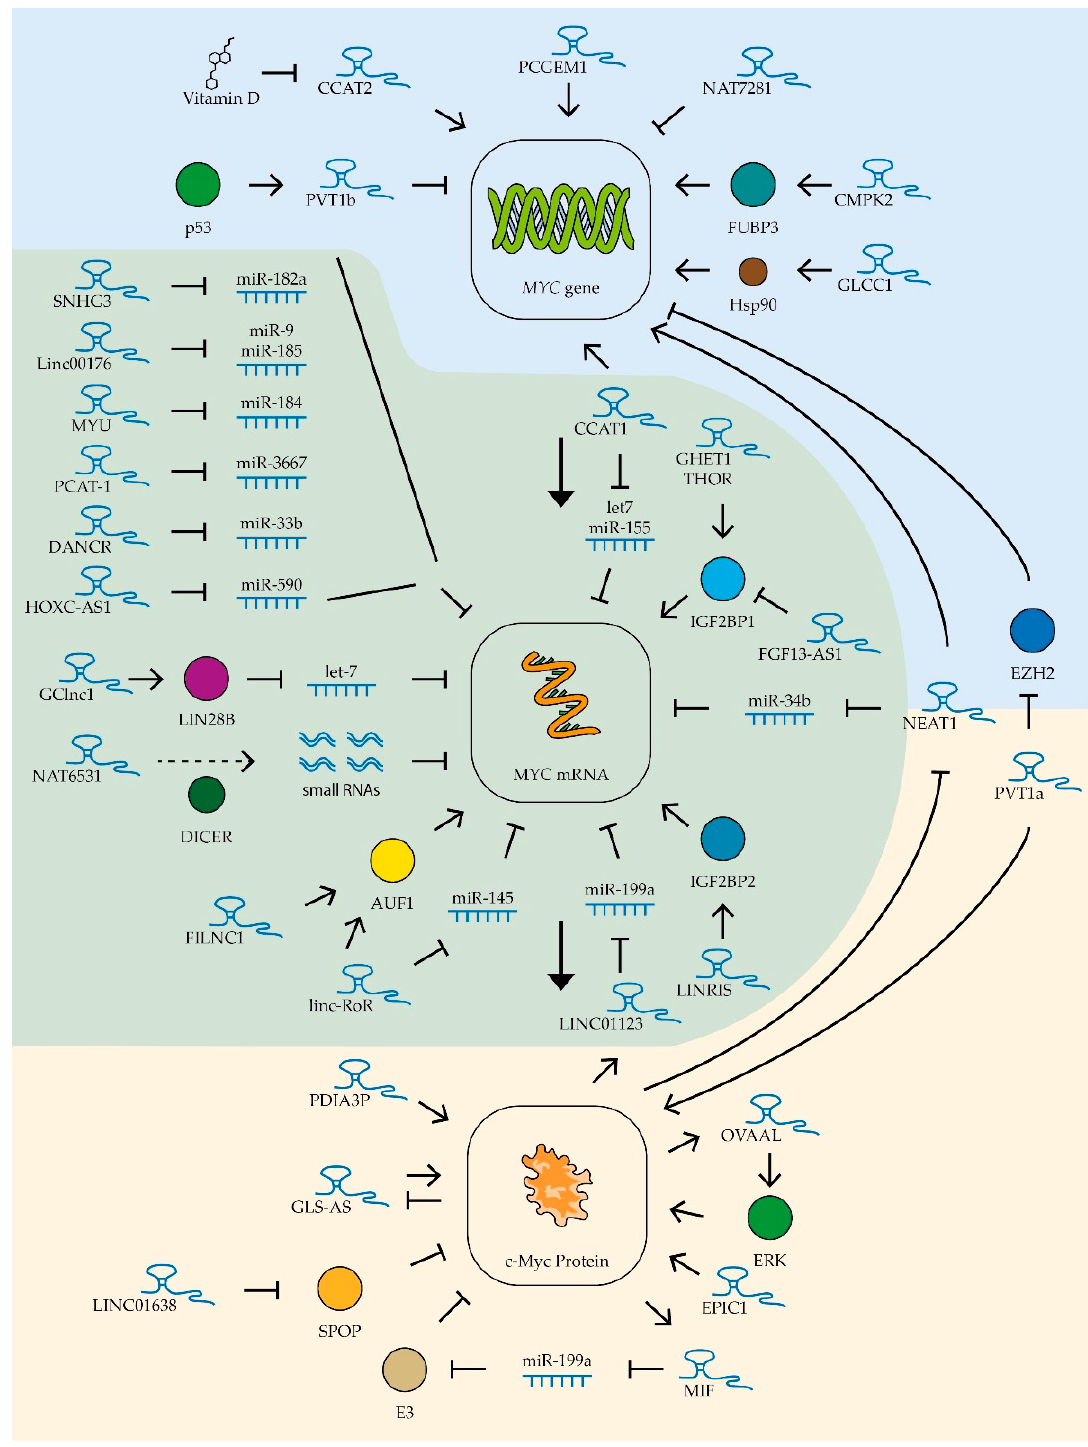
Figure 4. Control of MYC expression by lncRNAs. Schematic representation of lncRNAs’ influence on MYC gene transcription (blue zone), MYC mRNA (green zone), and c-Myc protein stability (yellow zone). The colored circles indicate the proteins included in the pathway, the dotted line is product processing. See text for description and references.